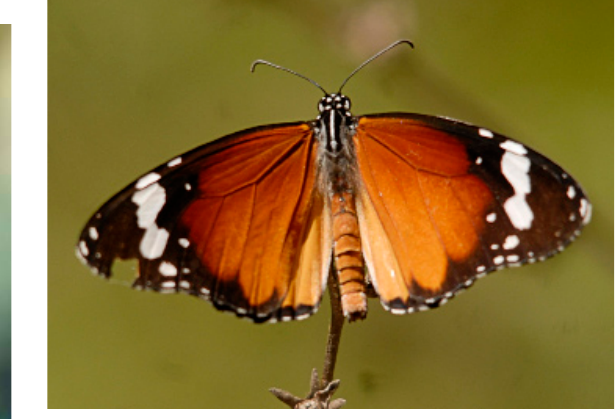
Image 9. Plain Tiger Danaus chrysippus